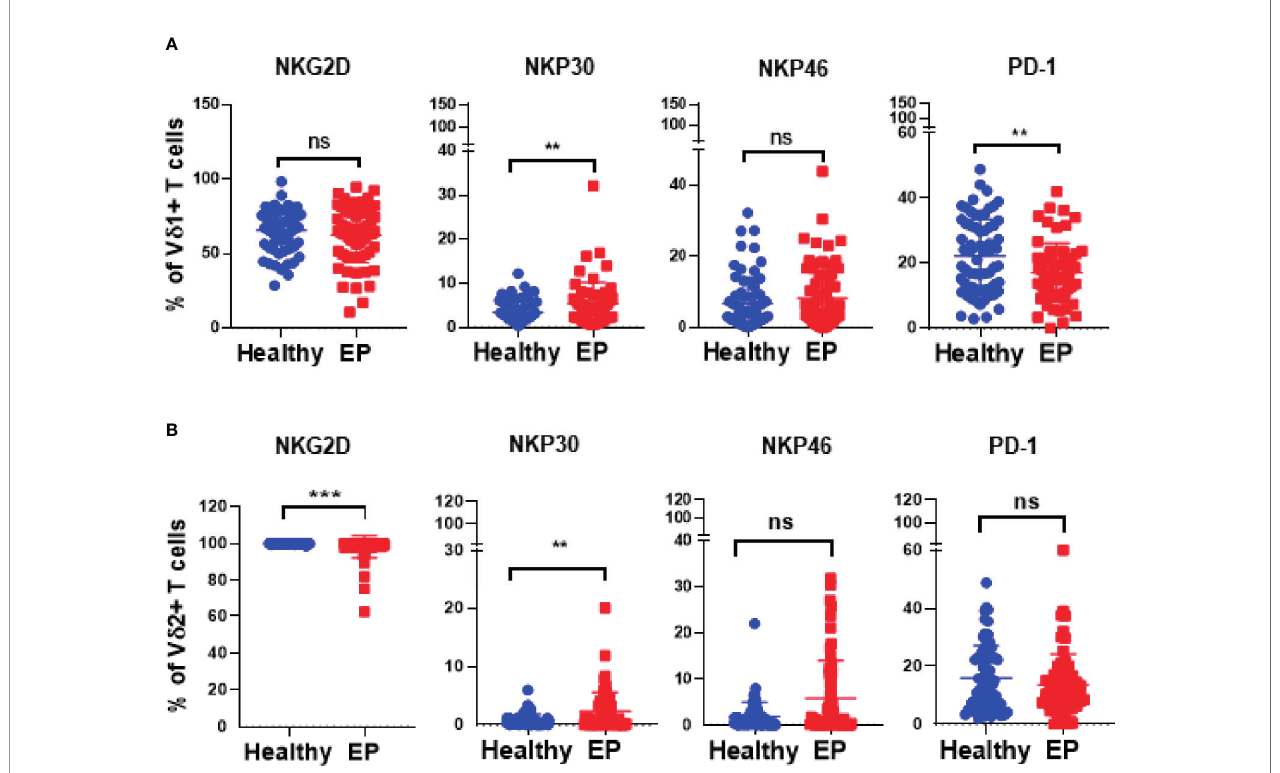
FIGURE 3 | Expressions of crucial receptors of V d 1 + and V d 2 + gd T cells in healthy and EP populations. (A) Comparison analyses of expressions of NKG2D, PD-1, NKP30, and NKP46 receptors of V d 1 gd T cells acquired by fl ow cytometry. (B) Expressions of NKG2D, PD-1, NKP30, and NKP46 receptors expressed in V d 2 cell subset. ns, no signi fi cance; **P < 0.01; ***P <